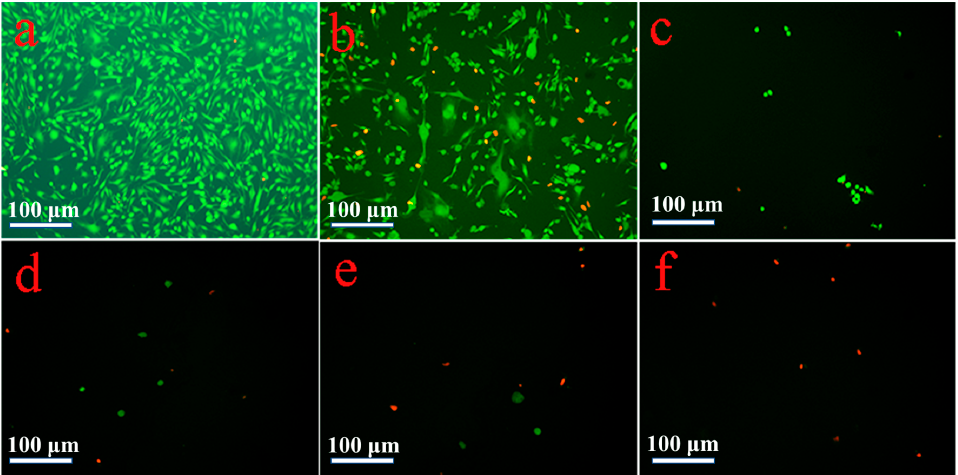
Figure 6. Cell numbers and viability evaluated using calcein-AM/ propidium iodide (PI) staining after 48-h seeding. ( a ) Control; ( b ) 25 μ g/mL; ( c ) 50 μ g/mL; ( d ) 75 μ g/mL; ( e ) 100 μ g/mL; and ( f ) 125 μ g/mL.